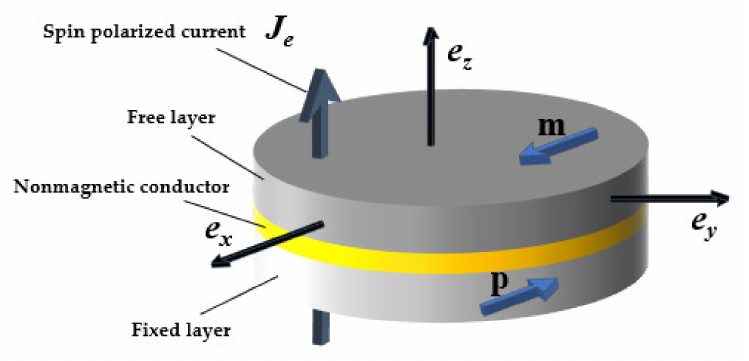
Figure 1. Schematic diagram of three-layer structure